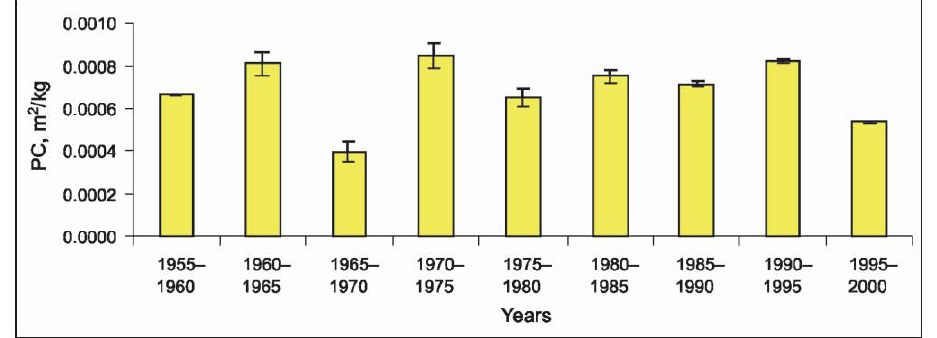
Fig. 3. Fluctuation of 137 Cs transfer coefficient from soil to pinewood (1 m from stump)